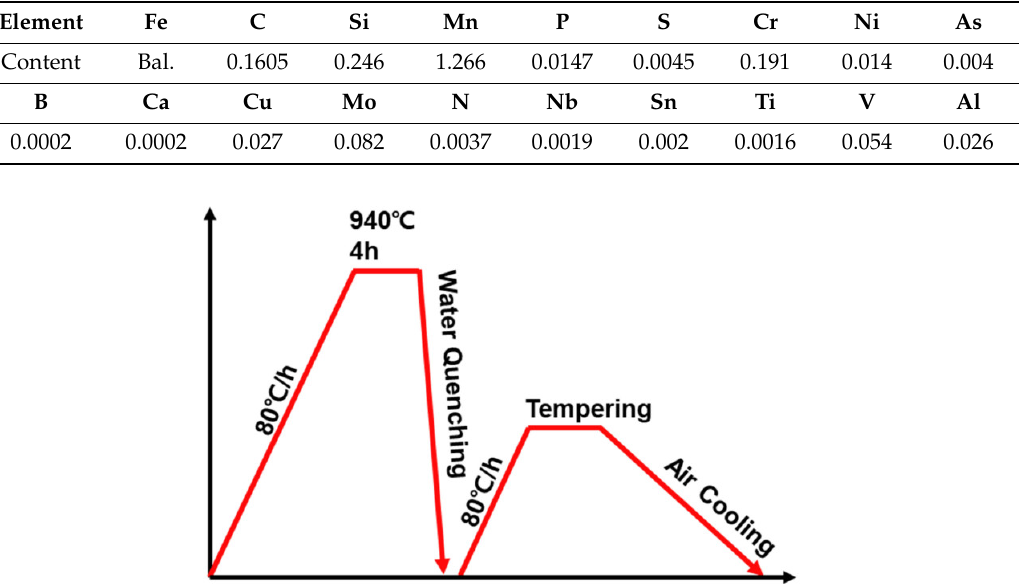
Table 2. Post-heat treatment conditions and symbols.